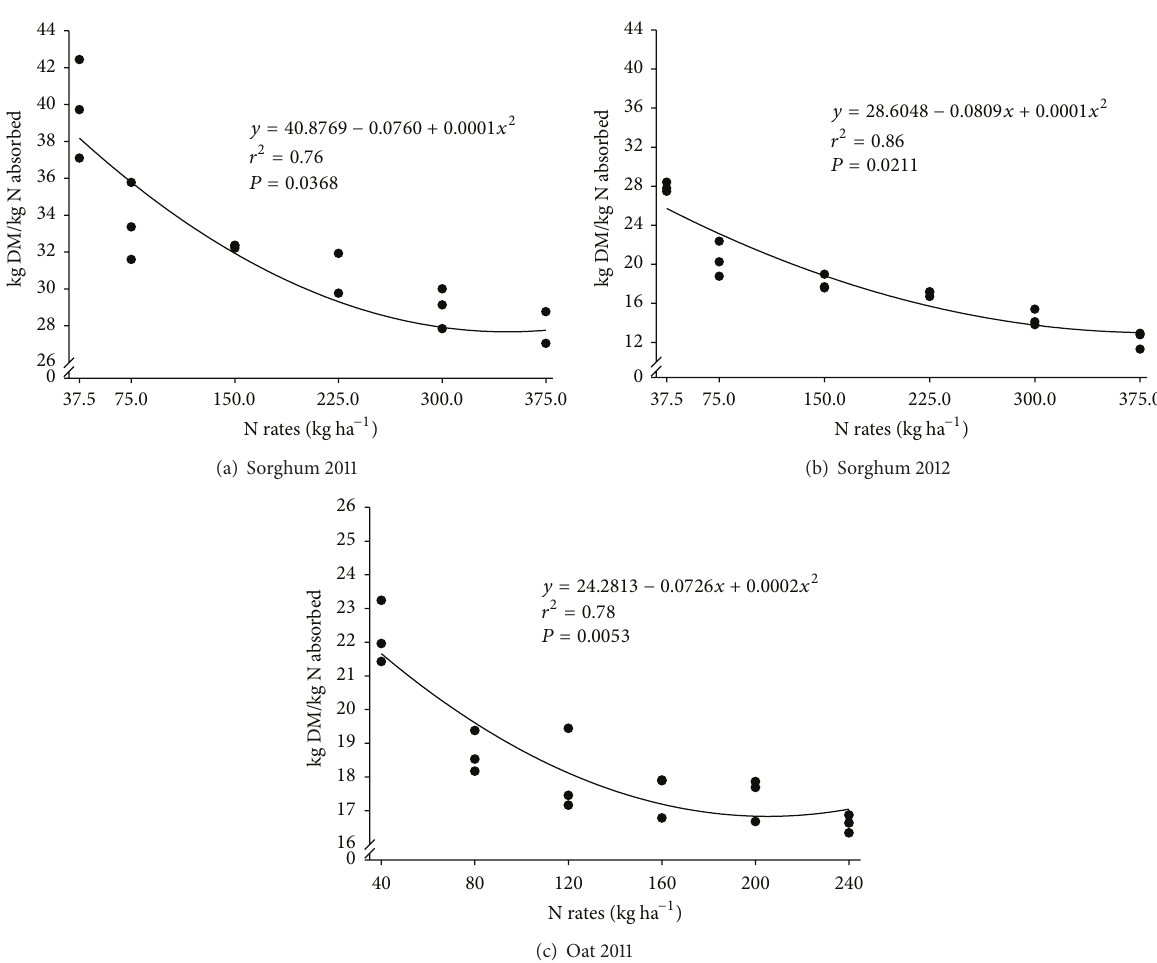
Figure 5: Physiological N efficiency (kgDMkg −1 N absorbed) by the forage of sorghum in the summer seasons of 2010/2011 (a) and 2011/2012 (b) and black oat in the winter season of 2011 (c), under nitrogen fertilization. from 15.40 to 68.10 Mg ha −1 , slightly lower than in the present work. The DM content was evaluated in sorghum-Sudan